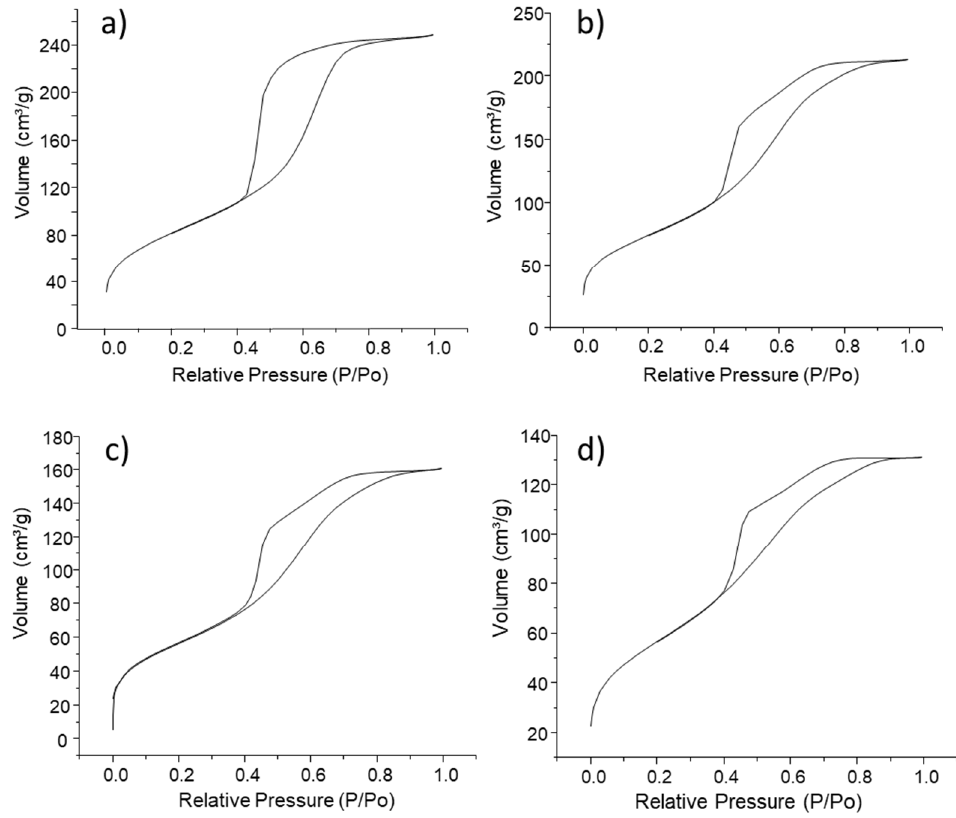
Figure 3. Adsorption/desorption of N 2 isotherms obtained for ( a ) MBG, ( b ) MBG-Zn1, ( c ) MBG-Zn3, and ( d ) MBG-Zn5.